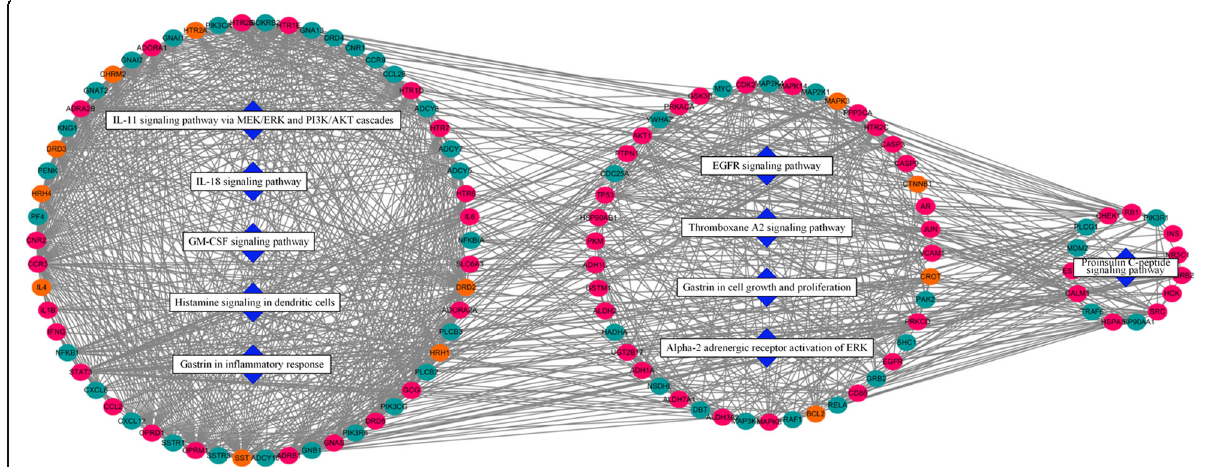
Fig. 3 The interaction network between major hubs and main pathways. Round red nodes stand for putative targets of ingredients contained in ZJW; round orange nodes stand for known therapeutic targets for gastritis; round green nodes stand for the main link targets between red nodes and orange nodes; blue diamonds stand for main pathways based on enrichment analysis of major